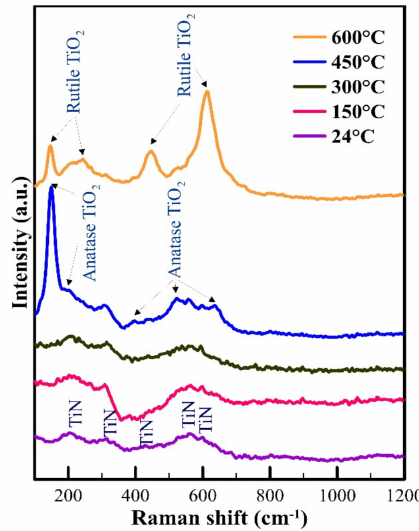
Figure 9. Raman spectra of HiPIMS-TiN coatings annealed at di ff erent